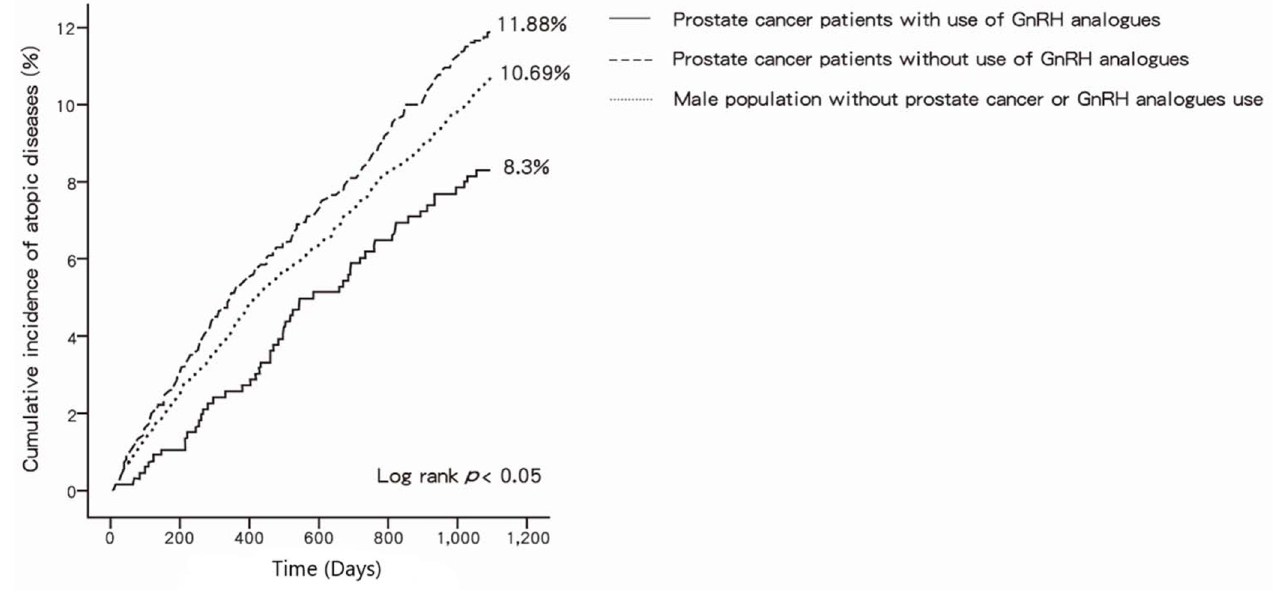
Fig 2. Cumulative incidence of atopic diseases.